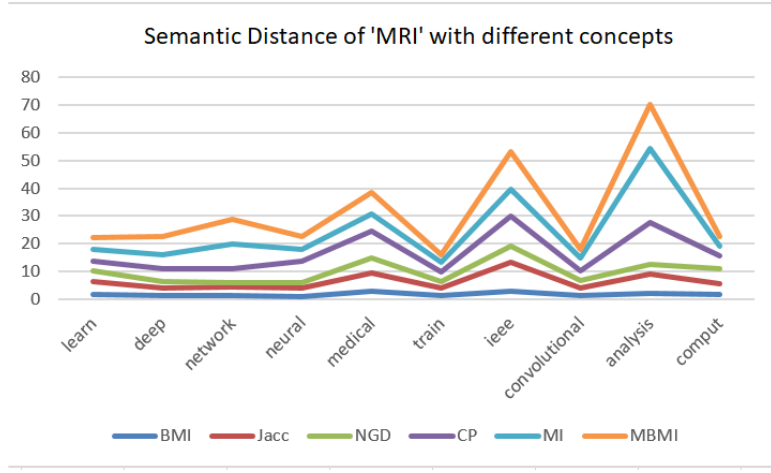
Figure 11. Semantic Distance of term “MRI” with cross domain terms using different techniques